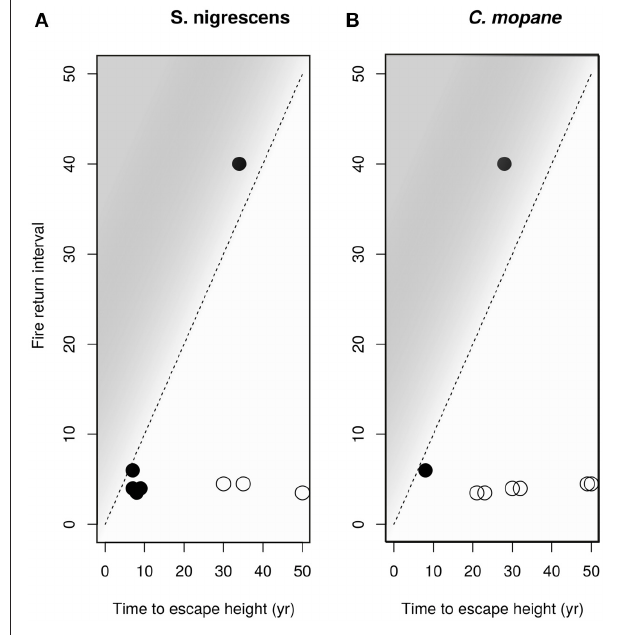
FIGURE 8 | The modeled time to reach escape height in the presence of grass plotted against the approximate fire return period for the site for (A) S. nigrescens and (B) C. mopane . Closed circles show a species was planted within its distribution range, open circles show the plant was grown outside its distribution range. The dashed diagonal line indicates the minimum fire return interval required for each time-to-escape-height value. If the points fall above the 1:1 line, into the shaded area, the plants have a high probability of escaping from the fire trap. Both species, if planted within their distribution range, have a reasonable probability of escaping the fire trap. Estimated growth rates are too slow for saplings to escape the prevailing fire regimes outside their distribution